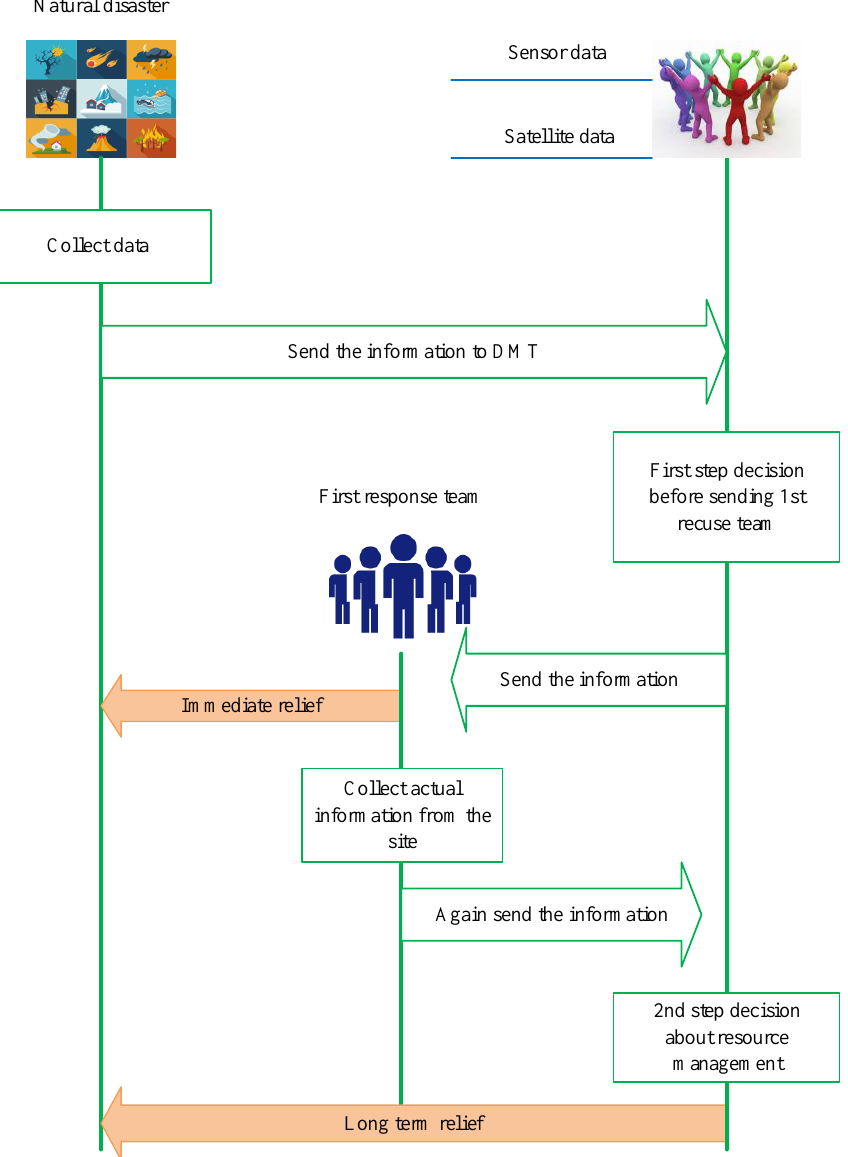
Figure 7. All activities of the